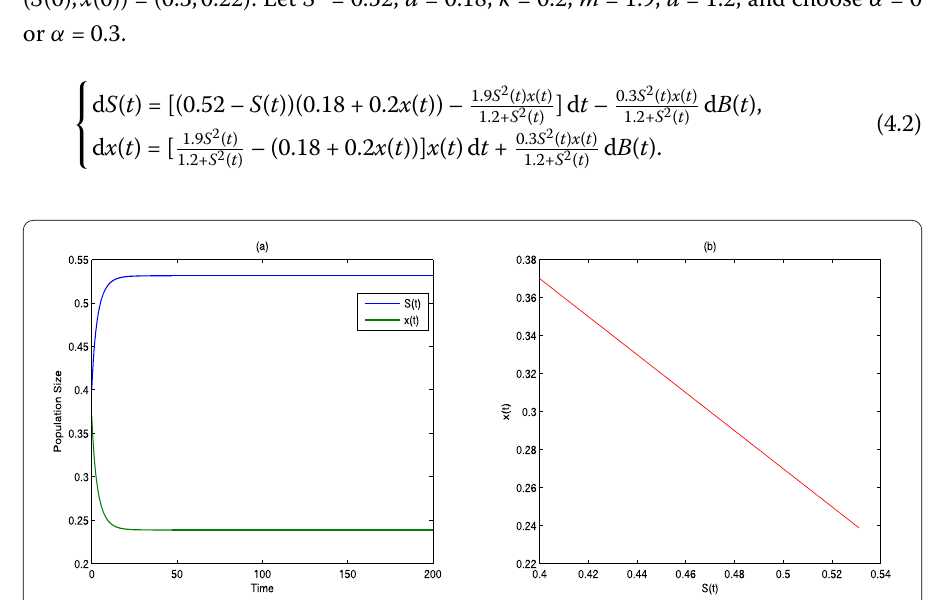
Figure 1 The time series and portrait phase of model (4.1) when α = 0. ( a ) is the time series of S ( t ) and x ( t ); ( b ) is the portrait